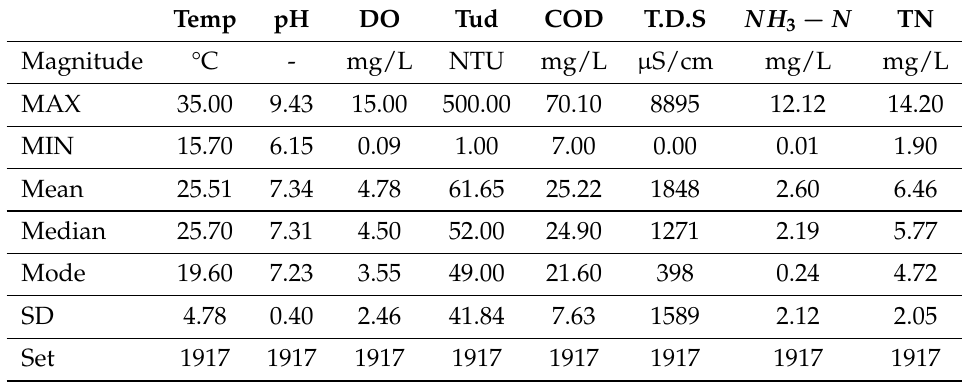
Figure 4. The geographical location of the Lianjiang River and Haimen Bay. Table 1. Several characteristics of water quality